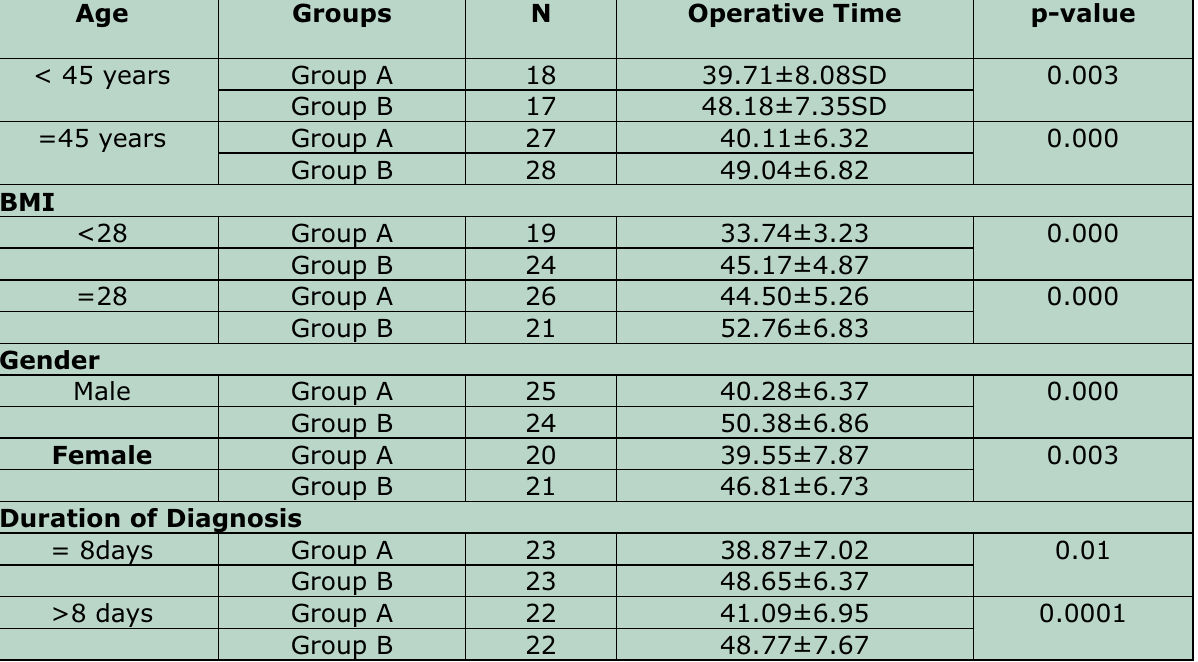
Table-II: Stratification of mean operative time in both groups with respect to age, BMI, gender and duration of diagnosis.